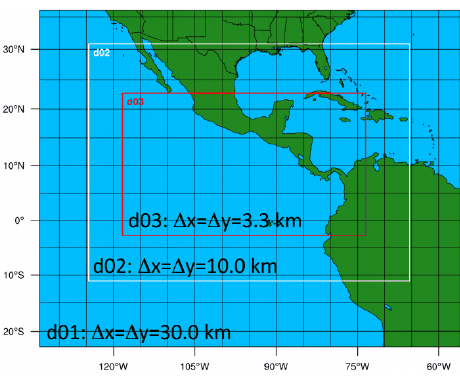
Figure 5. The domain map of WRF nested simulations.